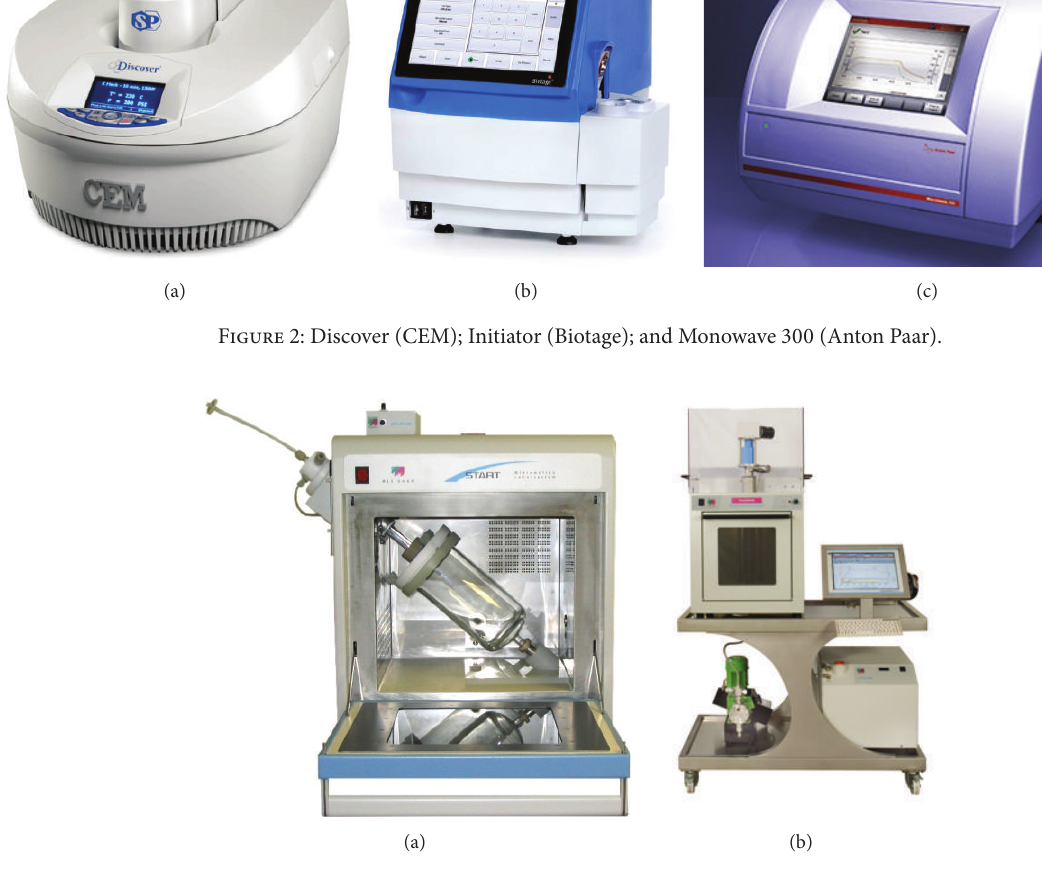
Figure 3: RotoSynth and FlowSynth